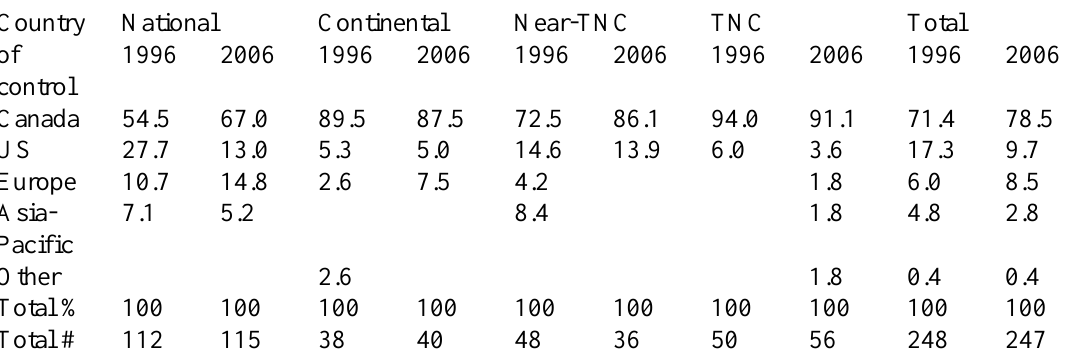
Table 4. Transnationality and National Locus of